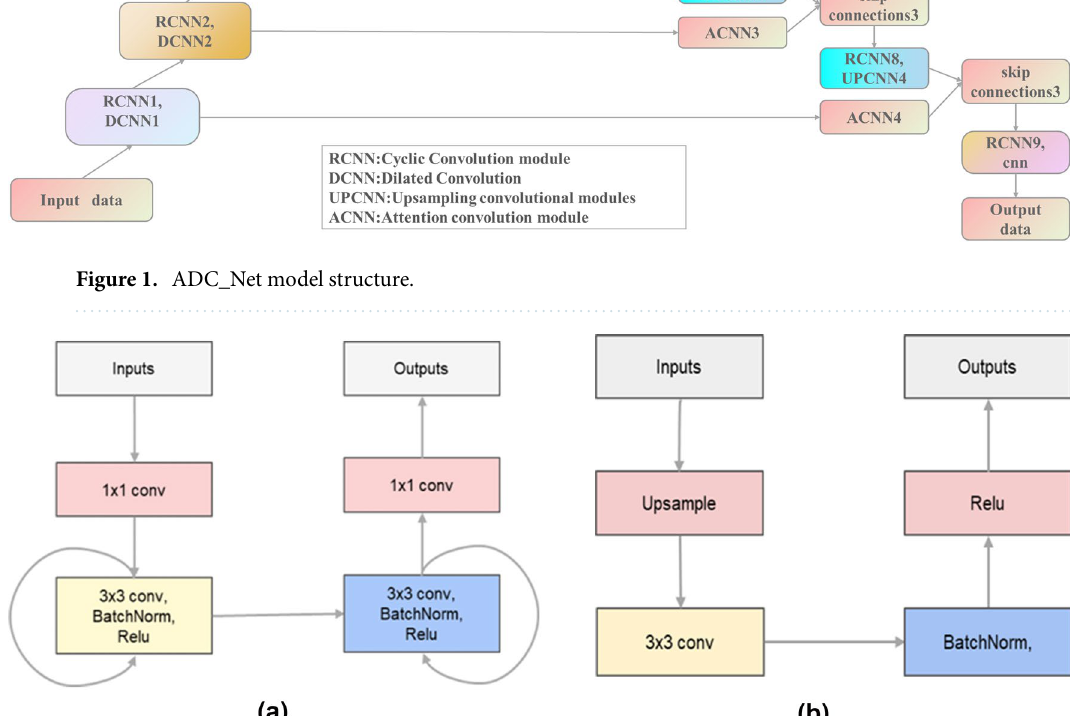
Figure 2. ( a ) RCNN module, ( b ) UPCNN